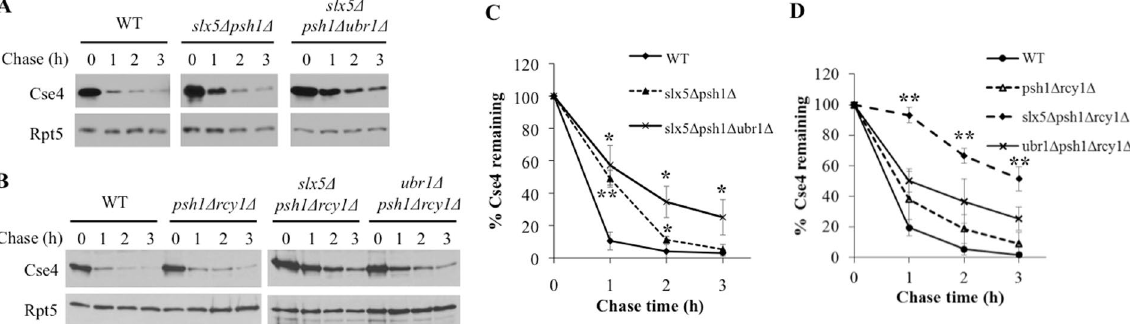
Figure 6. Functional relationships among Ubr1, Slx5, Psh1 and Rcy1. ( A–D ) Cse4 stability was determined and quantified in wild-type and mutant cells bearing various combinations of rcy1 Δ , psh1 Δ , slx5 Δ , ubr1 Δ